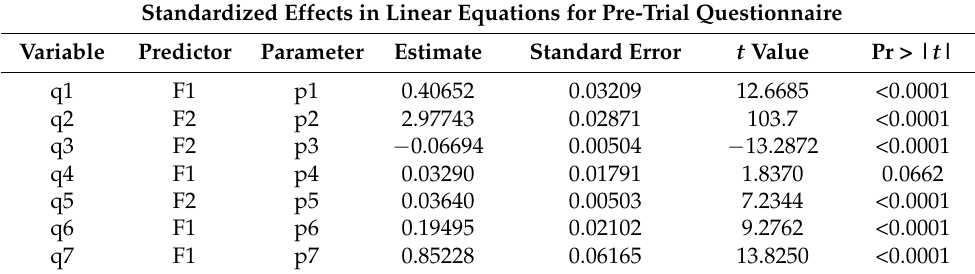
Table 8. Factor loadings for the pre-trial questionnaire data